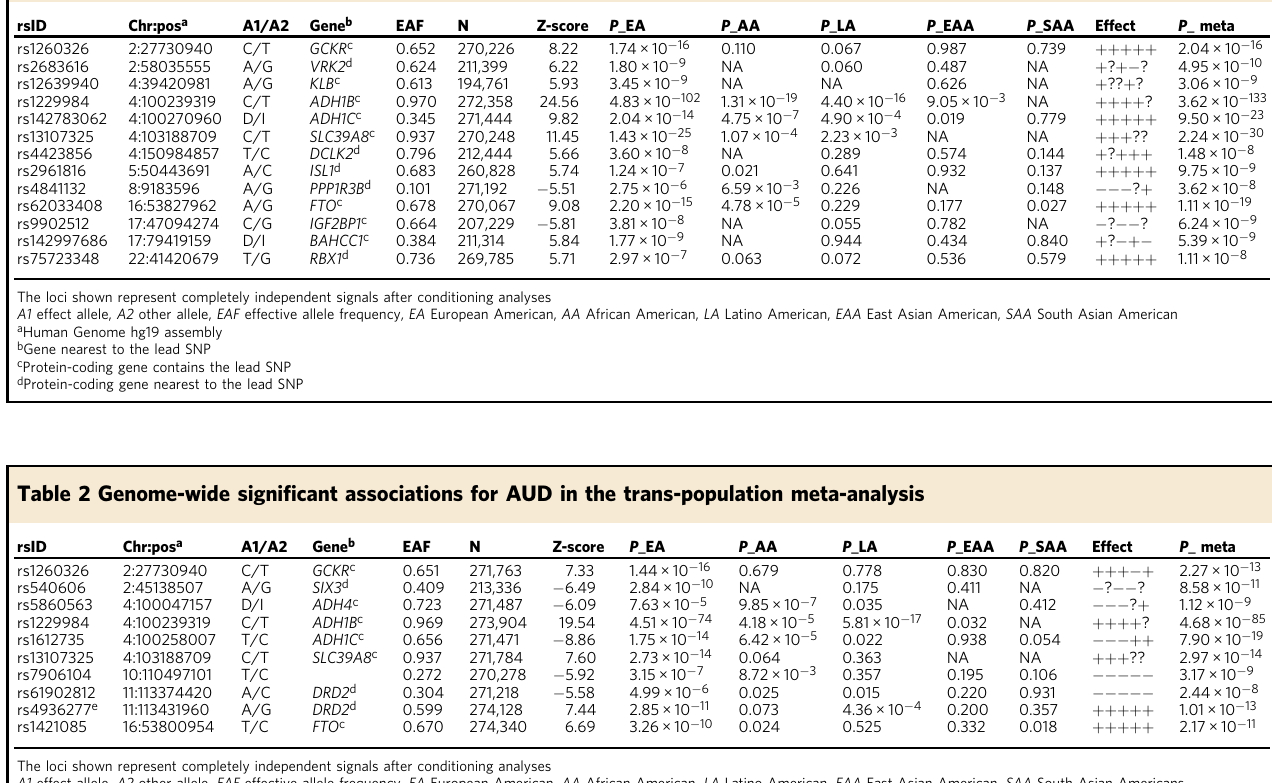
The loci shown represent completely independent signals after conditioning analyses A1 effect allele, A2 other allele, EAF effective allele frequency, EA European American, AA African American, LA Latino American, EAA East Asian American, SAA South Asian Americans a Human Genome hg19 assembly b Gene nearest to the lead SNP c Protein-coding gene contains the lead SNP d Protein-coding gene nearest to the lead SNP e Different signal than